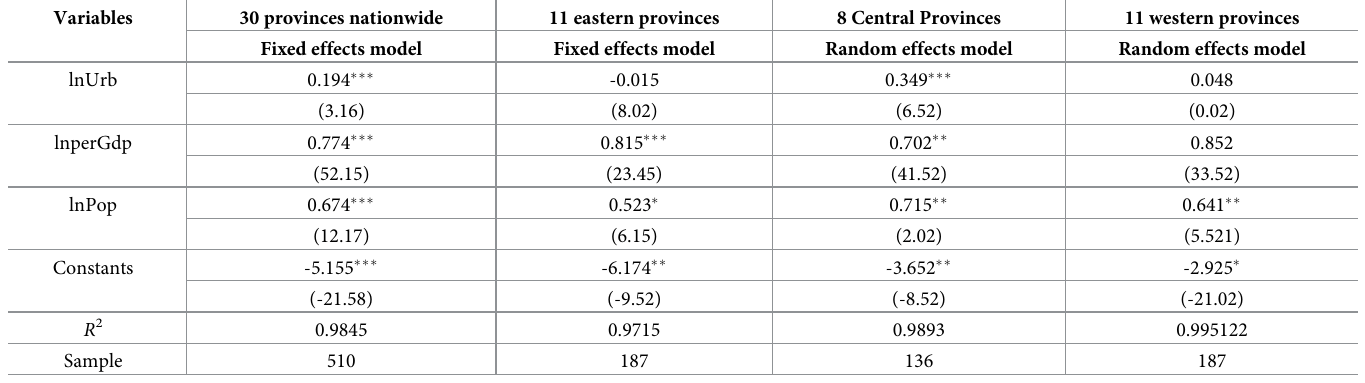
Table 5. Estimation results of the residential indirect energy consumption